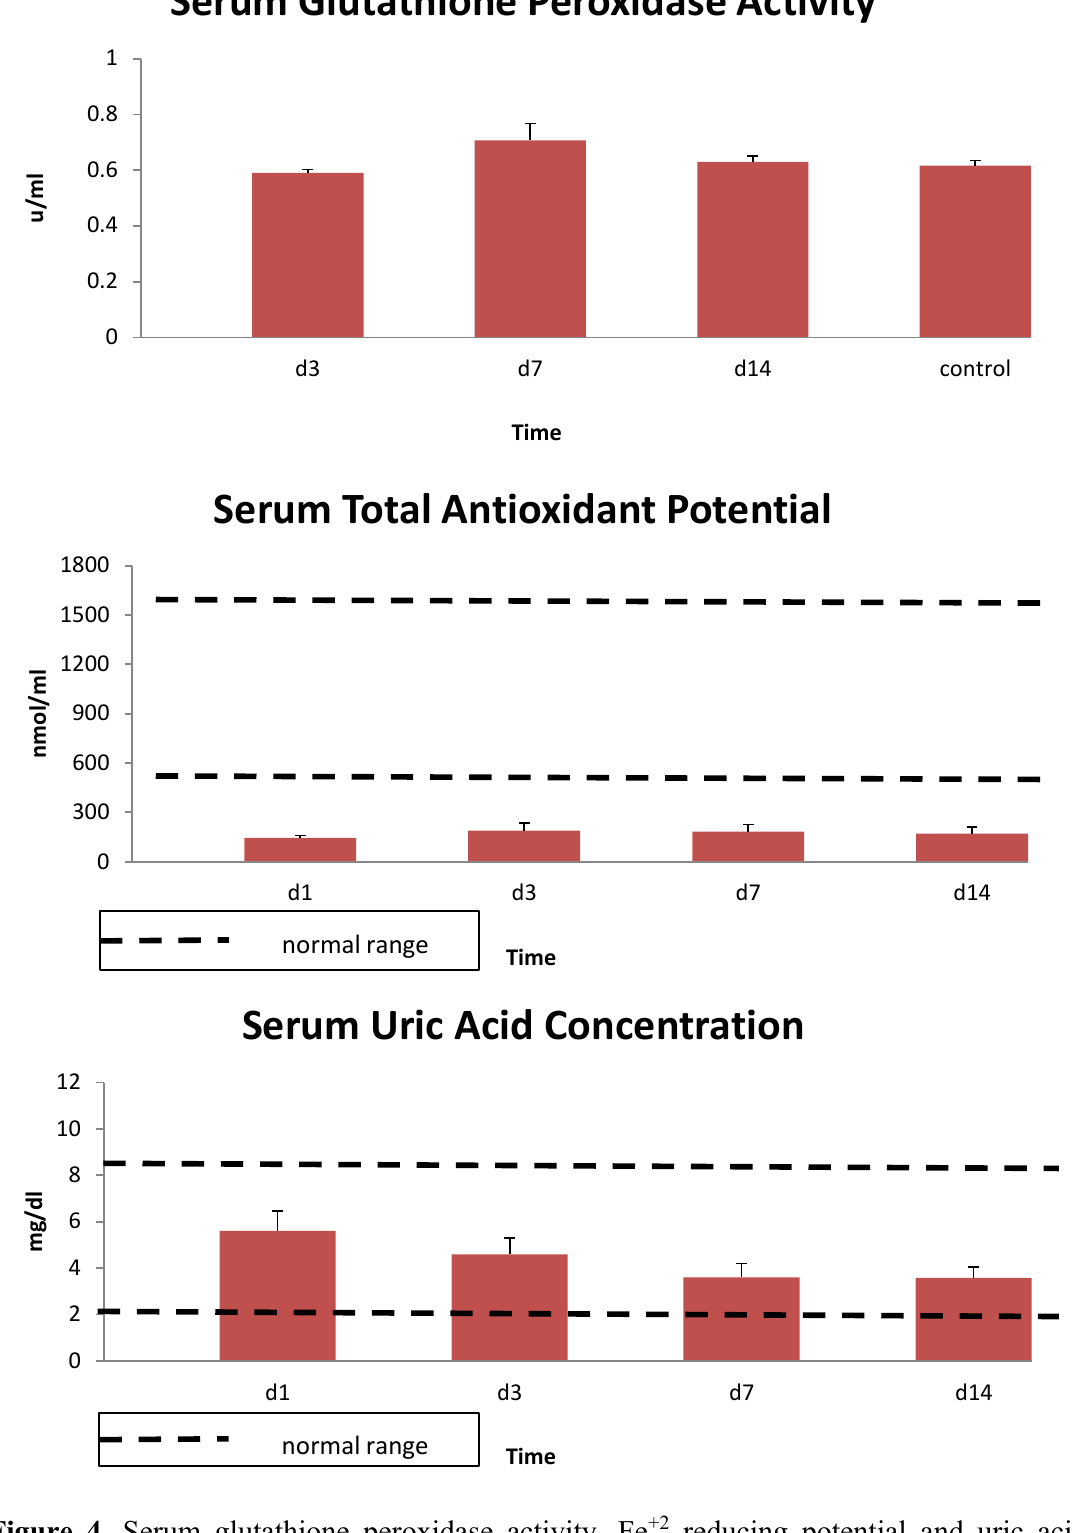
Figure 4. Serum glutathione peroxidase activity, Fe +2 reducing potential and uric acid concentrations in 10 thermally injured subjects. Data expressed as mean ± SE. Dotted lines denote the upper and lower normal